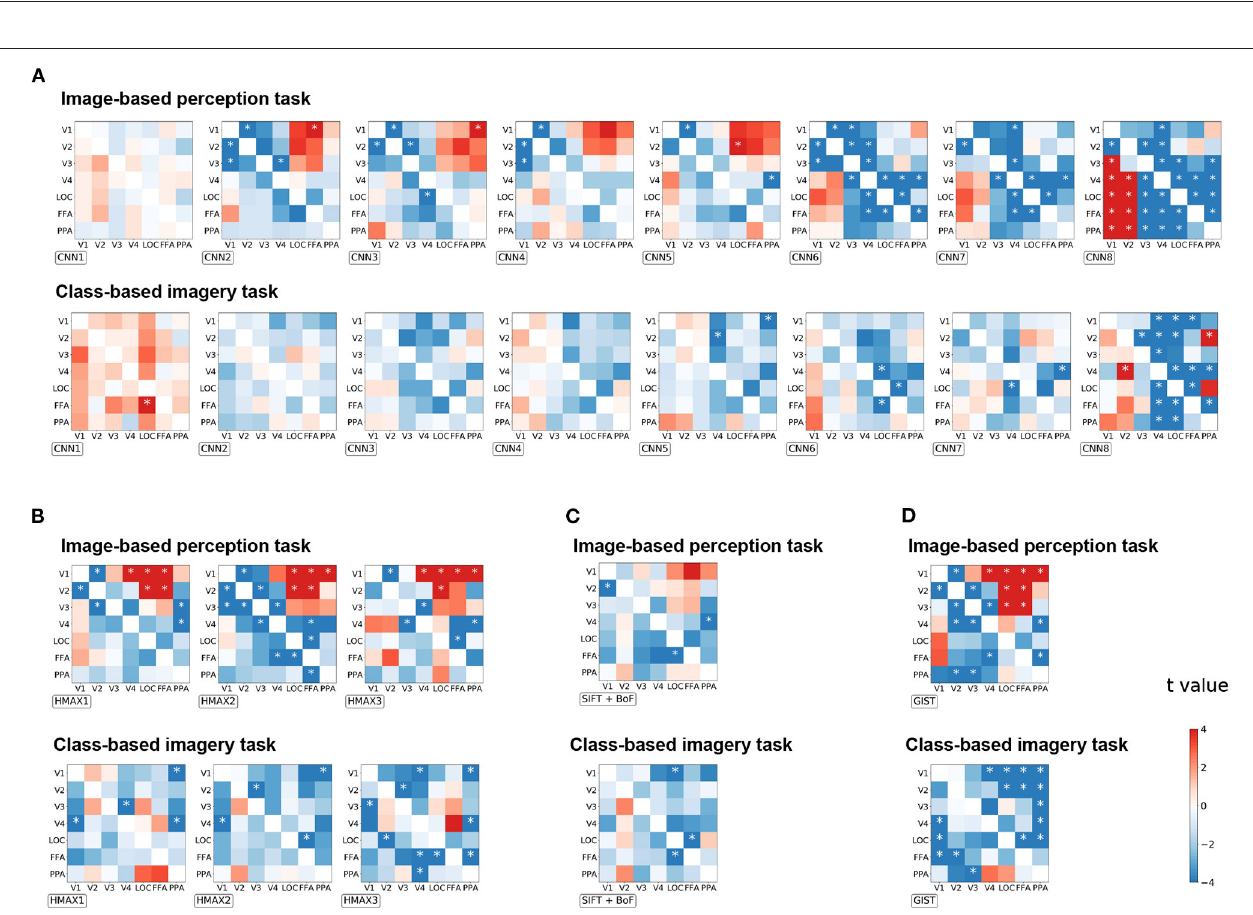
FIGURE 4 | The effect of distillation according to each seed–target pair for image-based perception task and class-based imagery tasks across all groups of visual features. (A) CNN visual features, (B) HMAX visual features, (C) SIFT + BOF, and (D) GIST. The difference of the correlation coefficients before and after distillation is arranged into a 7 × 7 matrix for every visual feature. For each group, the matrices are arranged as their complexity increased (from left to right). The diagonals are omitted since they represent the self-distillation which is not within the scope of this study. The horizontal axis represents the seed ROIs, whereas the vertical axis represents the target ROIs. The color bar indicates the t-value of the difference between the corresponding seed–target pair. * p < 0.05 after Bonferroni correction for multiple comparisons ( FWE < 5 % ); two-sided paired t -test after Fisher’s z-transform.